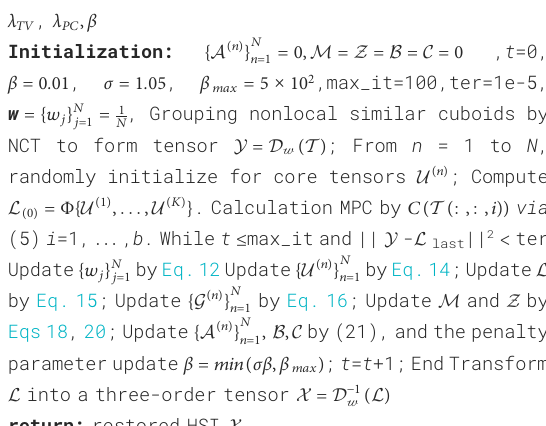
Algorithm 1 The whole procedure of the ATRFHS algorithm.